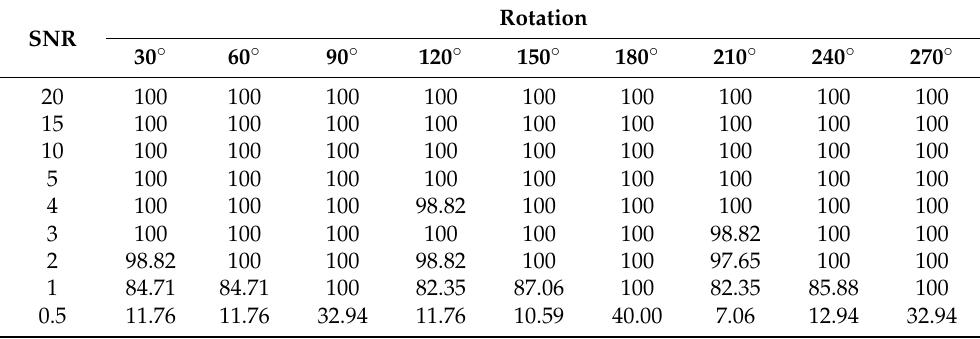
Table 9. The correct recognition rates for a combination of rotation angles and noise levels for the log-polar DWT-FFT2 method for the printed Chinese character